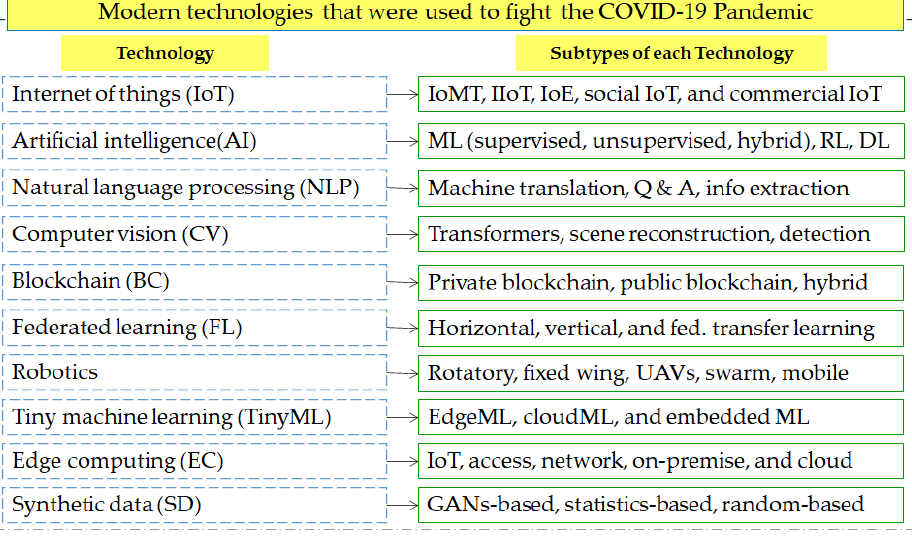
Figure 4. Top 10 digital technologies (DTs) and their subtypes that were used in the COVID-19 era to help mankind.